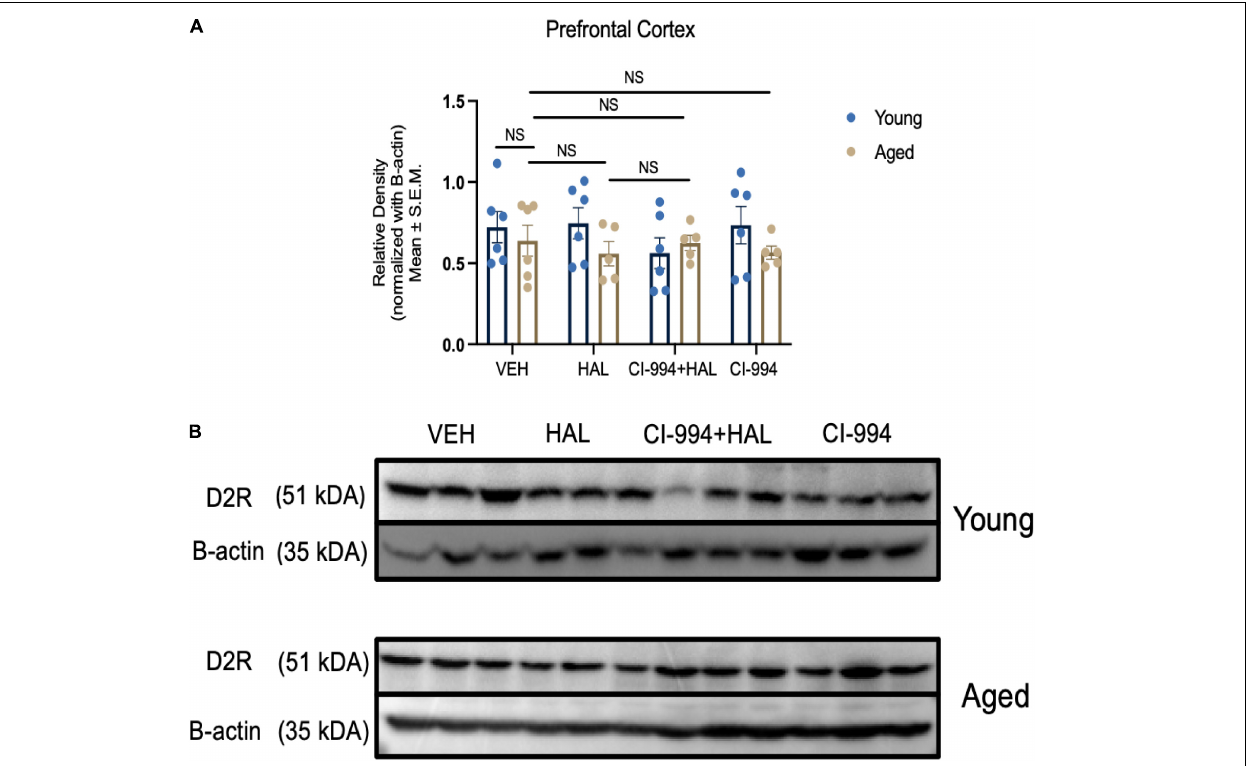
FIGURE 5 | CI-994 does not affect D2R protein expression in prefrontal cortex of aged mice (A) Quantitative analysis of D2R protein expression levels in the young and aged striatum through immunoblotting. Chronic treatment of CI-994 at 20 mg/kg in combination with HAL did not increase D2R protein expression in the prefrontal cortex of aged mice. (B) Western blot images from panel (A) . Each band represents a different biological sample in each treatment group. Data represent mean ± SEM ( n = 5–6/per